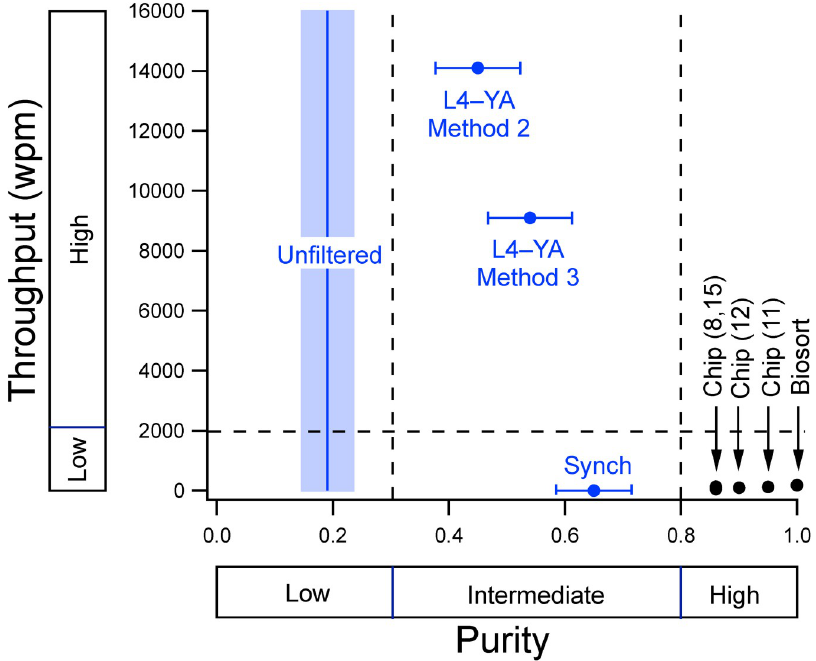
Fig 9. Comparison of enrichment methods along the dimensions of throughput, purity, and accessibility. Throughput is defined as the number of worms processed per minute. Purity is defined as the proportion of worms whose lengths are within the target zone (L4 and YA) when sorting from a mixed-stage population. The mean purity of unfiltered worms is indicated by the blue vertical line. Accessibility (high, blue symbols; low, black symbols ) is defined as the inverse of the magnitude of resources, facilities, and training required to make use of the method. Microfluidic chips and Biosort occupy the low-throughput, high-purity, low-accessibility sector. The L4–YA Methods 2 and 3 and synchronization occupy the high-throughput, intermediate-purity, and high-accessibility sector. Error bars and shading, 95% CI.